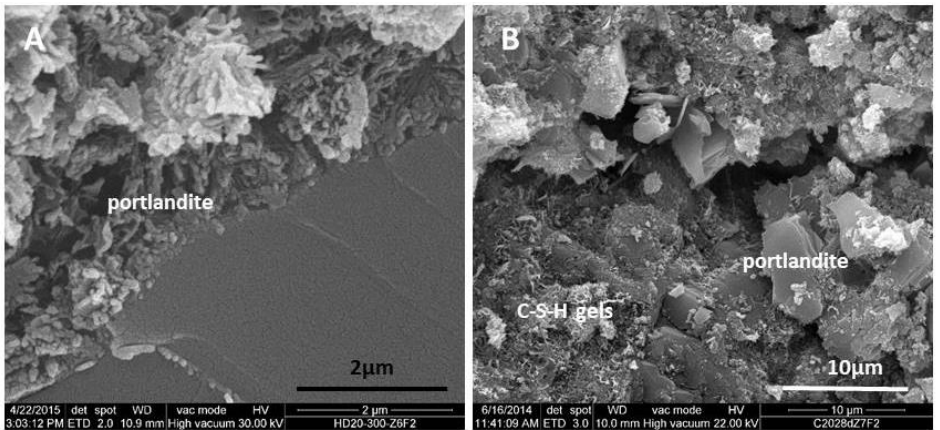
Figure 7. CPO sample without addition at one year of reaction. ( A ) Enlarged image of